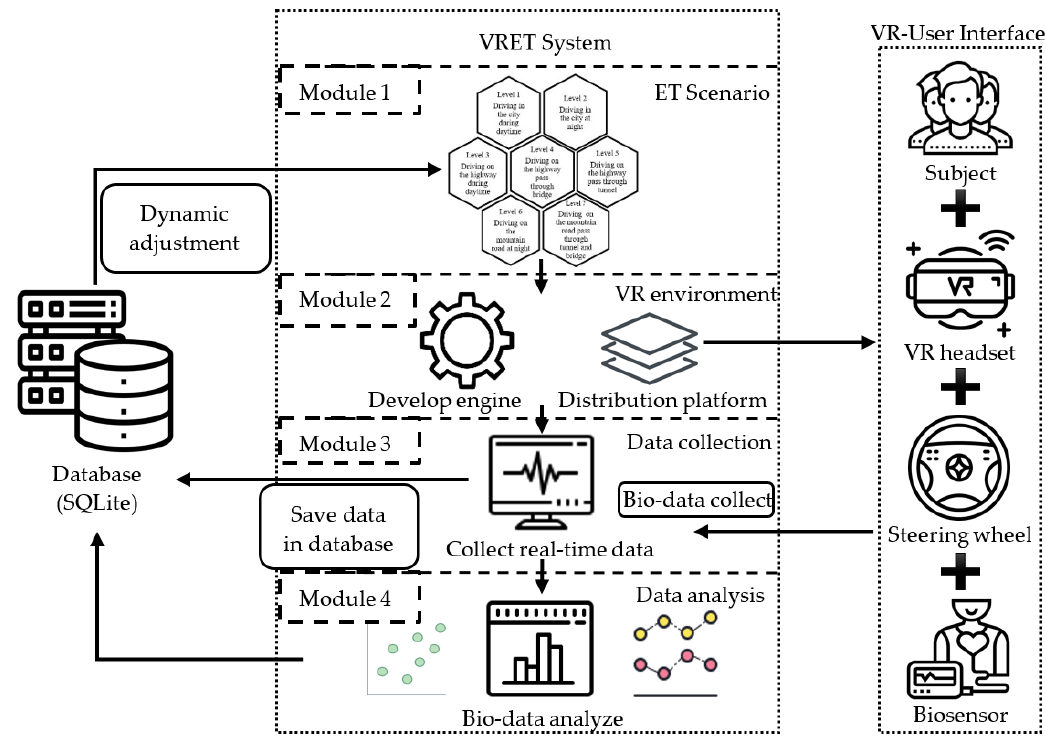
Figure 4. The system architecture for the driving phobia VRET prototype (refer to Figure 2 for Module 1 details).